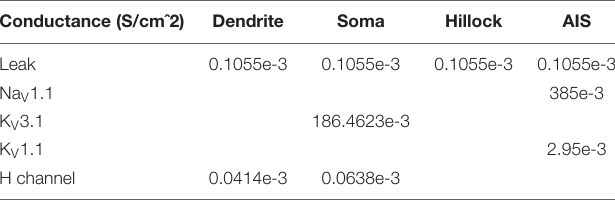
TABLE 1 | Conductance and distribution of ion channels.